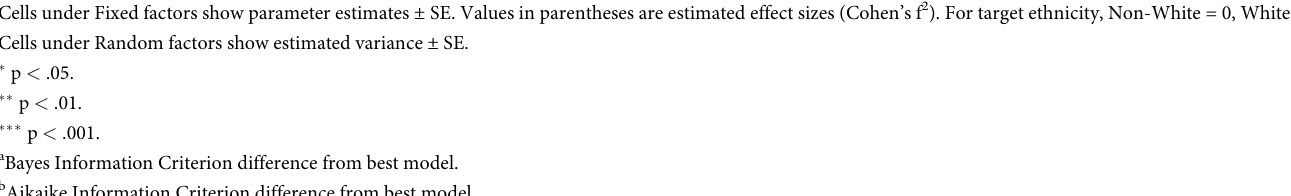
Table 5 shows the results of tests of models predicting judges’ LORP ratings of targets on secondary (F2) psychopathy. In the video with full audio condition, judge General Trust was related to LORP score, such that more trusting judges rated targets lower in secondary psy- chopathy. White targets were judged higher in secondary psychopathy than Non-White tar- gets. In the silent video condition, only target ethnicity was related to LORP F2 score. In the low-pass filtered video condition, White targets were judged higher in secondary psychopathy than Non-White targets, and target self-report was related (positively) to LORP score. Table 6 shows analogous model comparisons for total psychopathy. Judge general trust and tar- get ethnicity were related to LORP score in the video with full audio and the silent video conditions, whereas only target ethnicity was related to LORP score in the low pass filtered video condition. Models predicting accuracy (absolute value of self-other differences) in